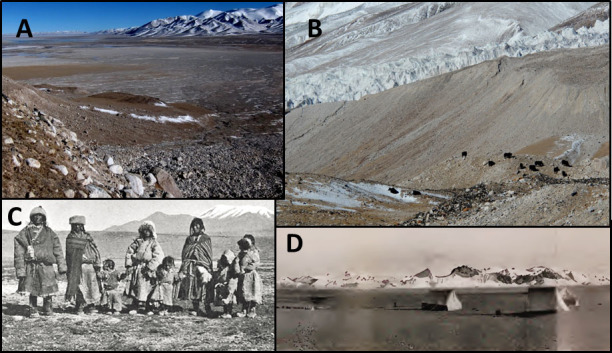
(A) Simple topography from 4,500–5,500 m typical of Tibetan Plateau habitats illustrating steppes (plains and valleys) and sloping hills into mountains and glaciers. (B) Female yak herd in peri-glacial zone, with some resting in snow patch. (C) Tibetan extended family (from Rawlins; SI22 and (D) topographies in “A” showing steppe habitat as reported in SI (photo from Hedin37). (Fig. 2A and B photographs by J. B.).